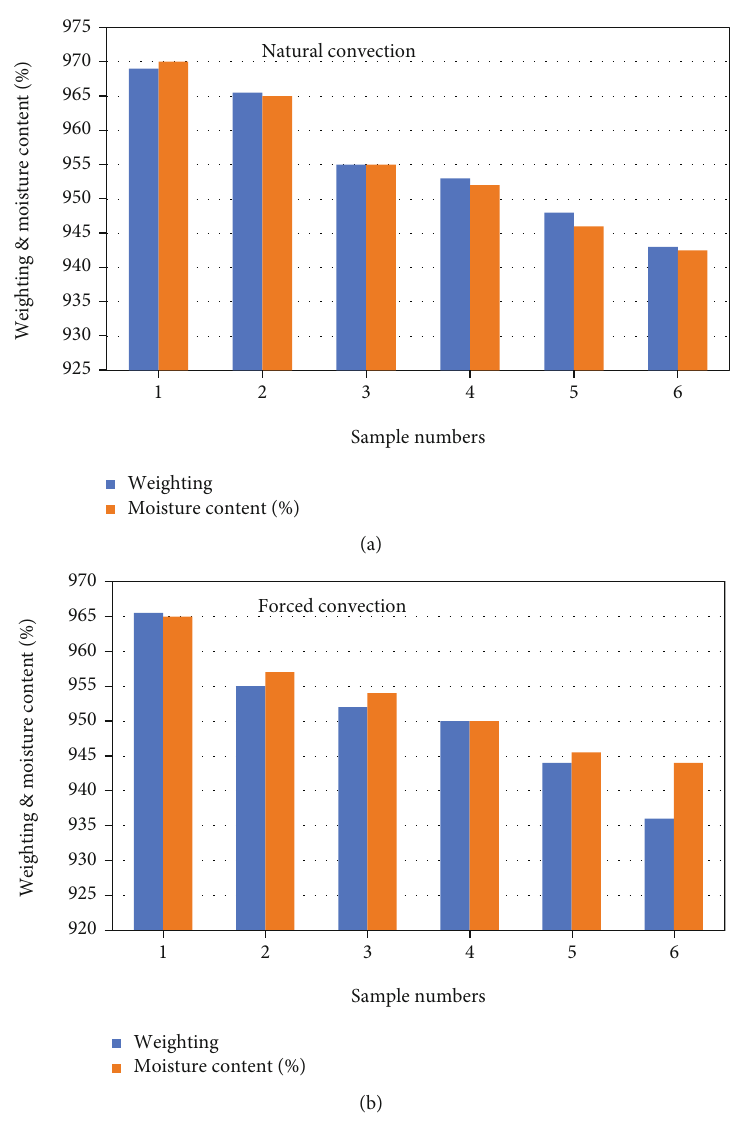
Figure 6: Variation of weight and moisture content in (a) natural and (b) forced